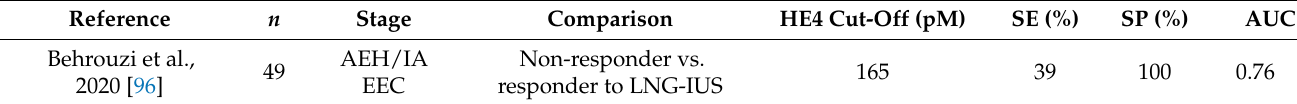
Table 3. Serum HE4 cut-off value and performance for LNG-IUS